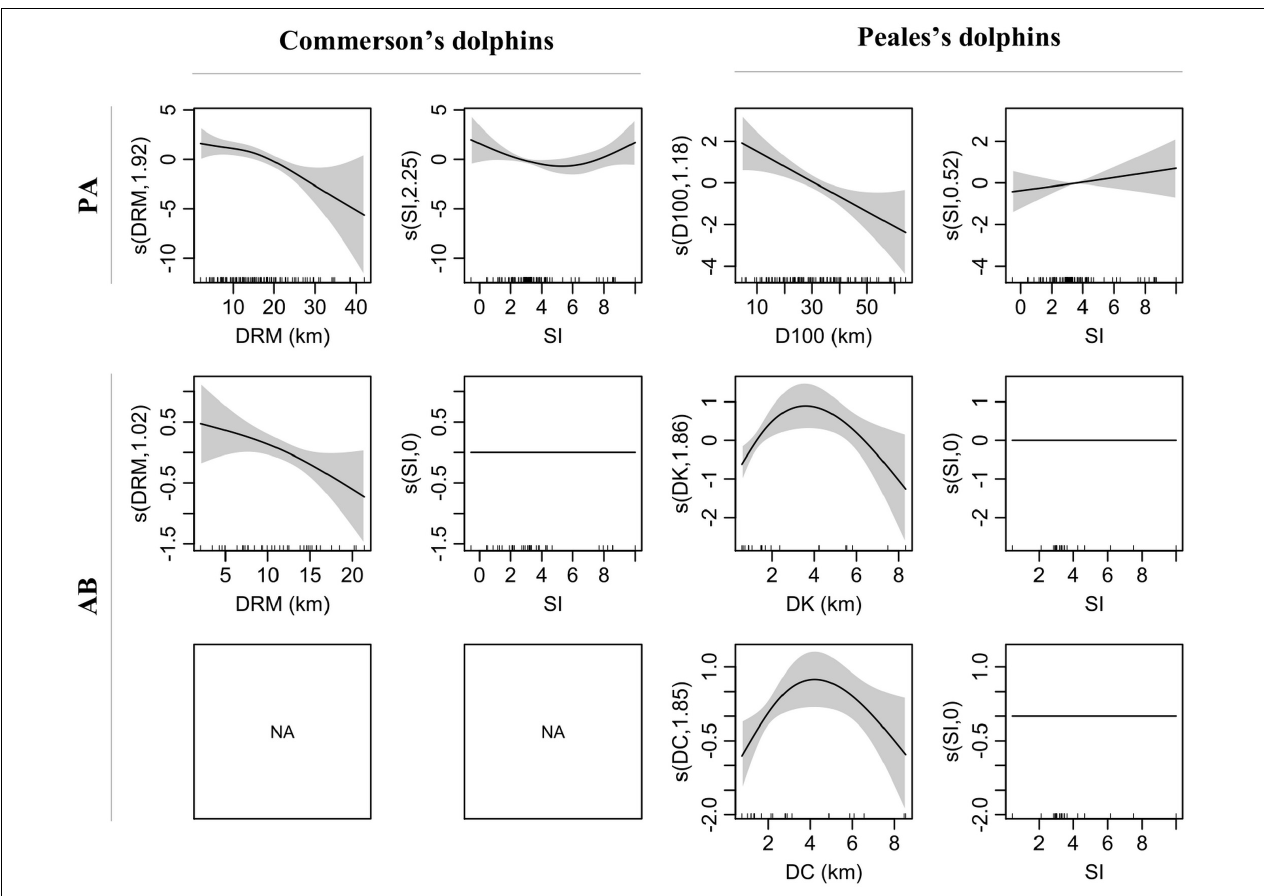
FIGURE 3 | Smooth terms (s, linear predictor scale) of selected variants for presence-absence (PA) and numbers of dolphins given presence (AB) sub-models for Commerson’s and Peale’s dolphins. Smooth term effective degrees of freedom (edf) in brackets on the y-axis. Shaded area = 95% confidence intervals. Internal ticks show covariate values covered by the observations. DRM, distance to river mouth; SI, water stratification index; D100, distance to 100 m isobaths; DK, distance to kelp; DC, distance to